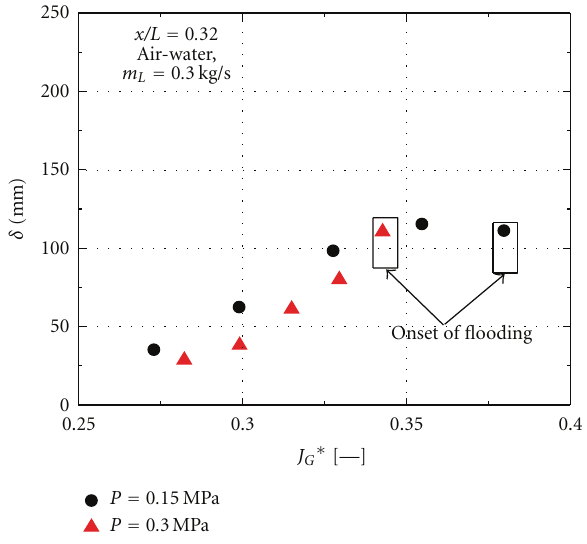
Figure 12: E ff ect of system pressure on the water level.